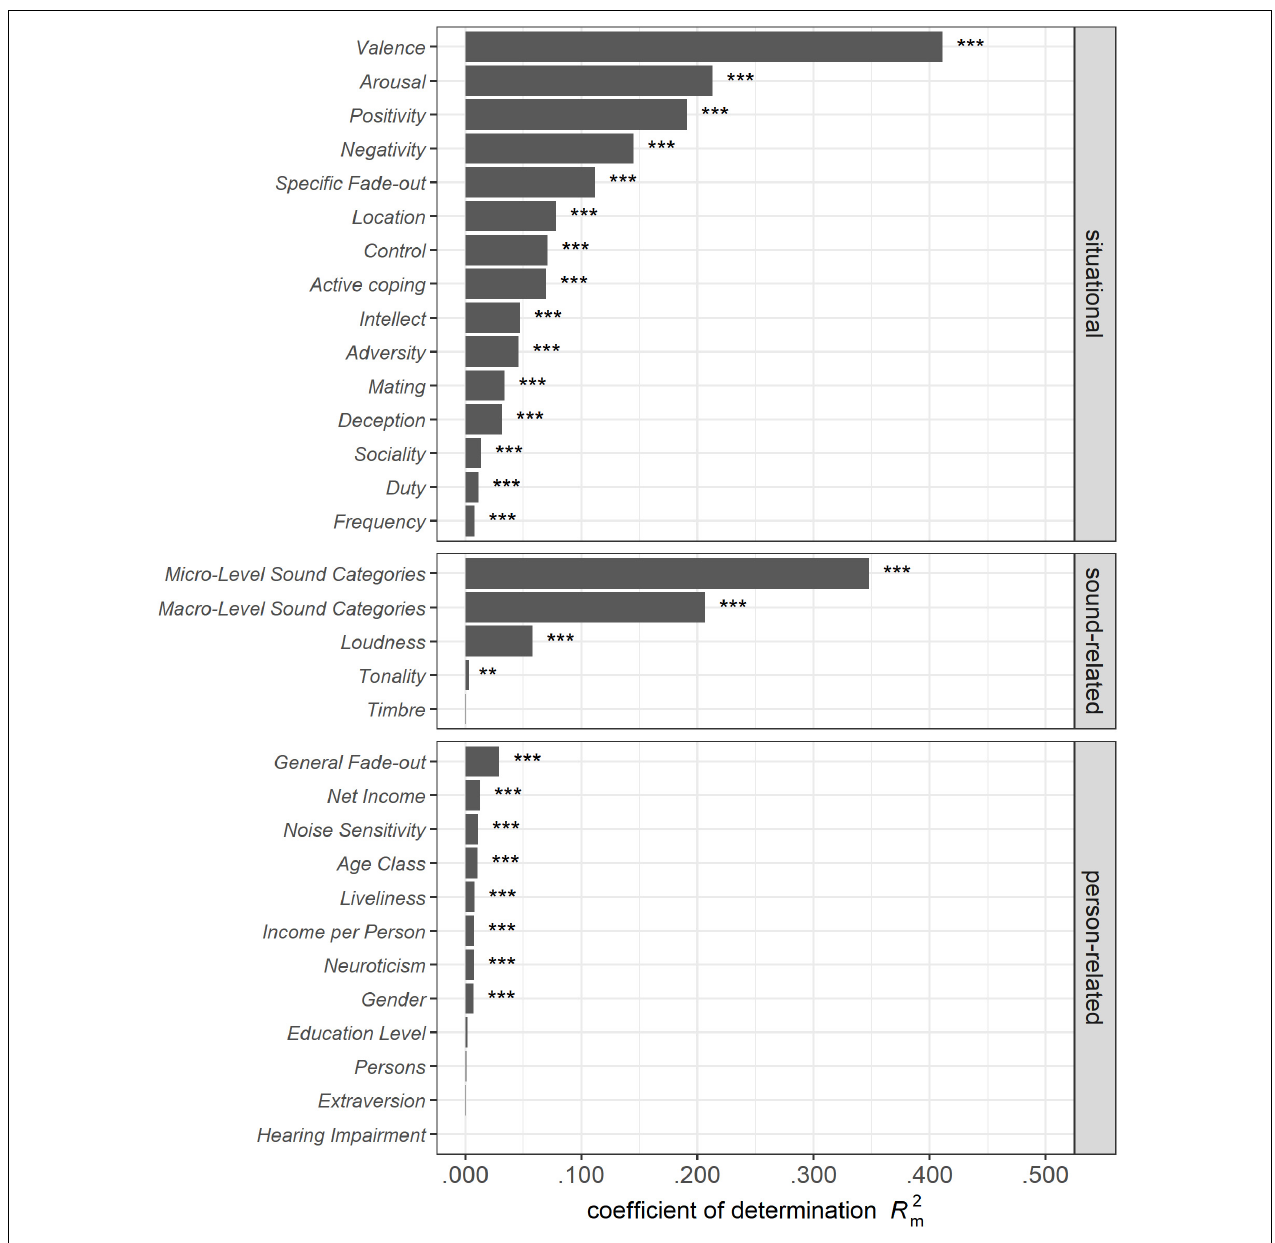
FIGURE 5 | R 2 m and probabilities for the assessed variables determined by bivariate analyses of the single-fixed-factor models. Probabilities are given as ∗∗∗ p < 0.001; ∗∗ p < 0.010; ∗ p < 0.050. Model 32SFFA .